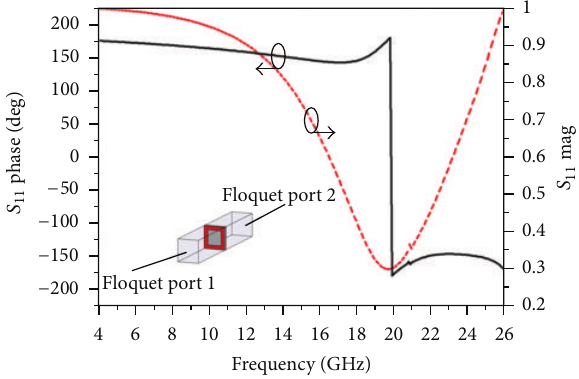
Figure 6: Reflection coefficient ( 𝑆 11 ) phase and magnitude of the